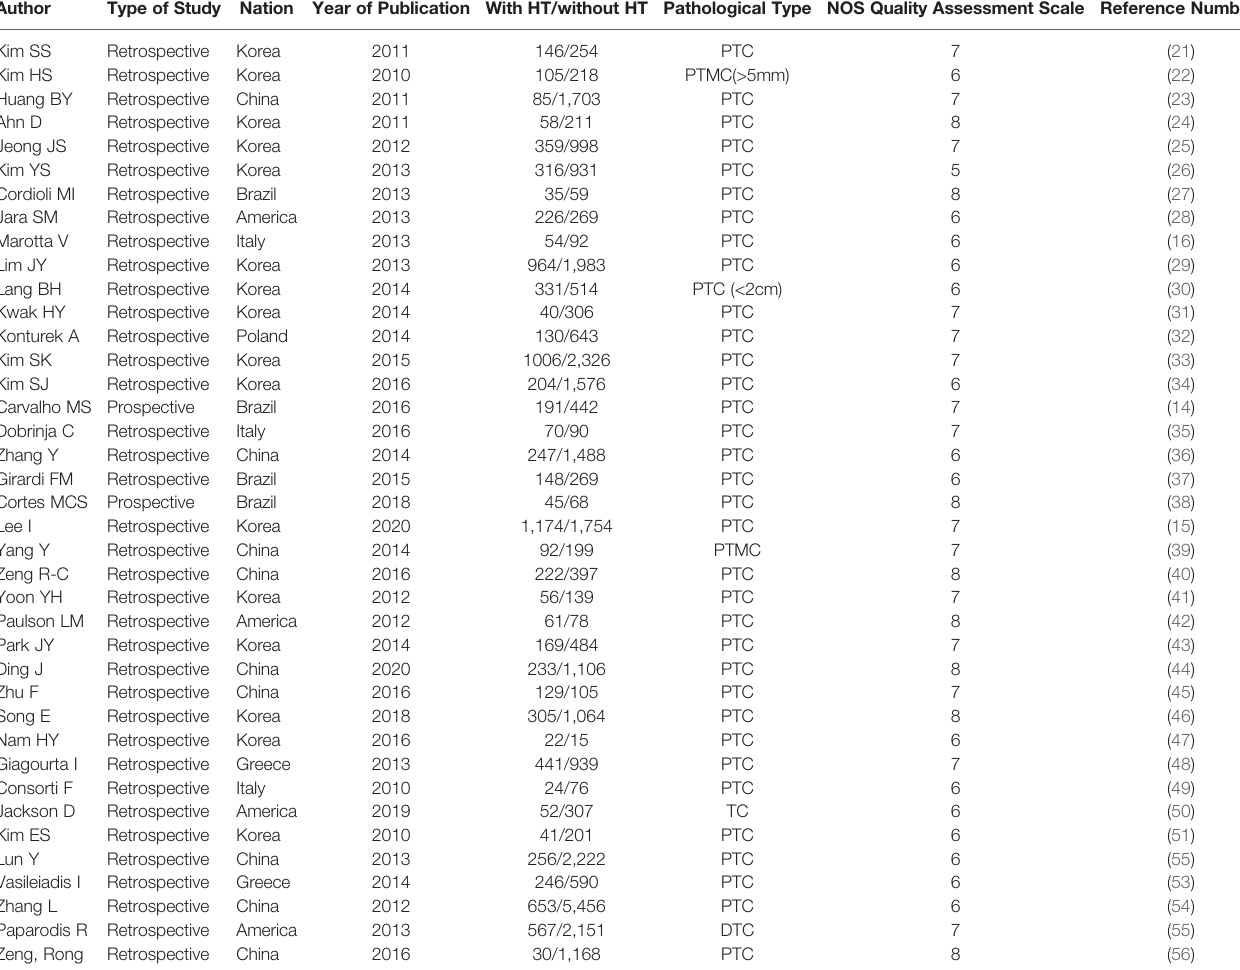
TABLE 1 | The clinical characteristics of included